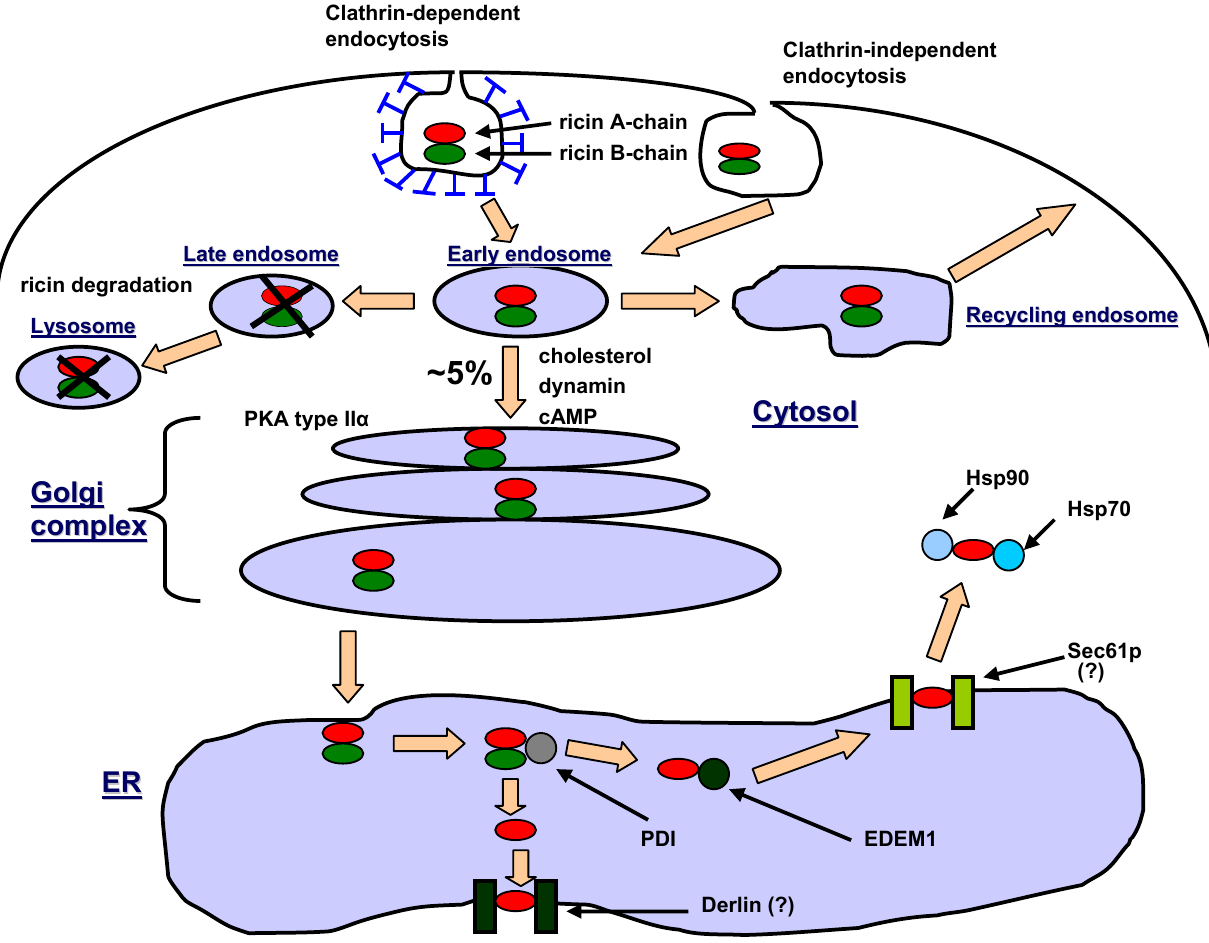
Figure 2. Intracellular transport of ricin. Ricin endocytosis can occur both by clathrin- dependent and clathrin- and caveolae-independent mechanisms. From early endosomes the majority of the endocytosed toxin recycles back to the cell surface, starts to be degraded and proceeds to late endosomes/lysosomes where further degradation is conducted. A minor fraction (~5%) of ricin is transported from early endosomes to the trans-Golgi network (TGN), circumventing late endosomes. As indicated, dynamin, cholesterol, cAMP and PKA type II α have been implicated in endosomes to Golgi transport of ricin. Ricin is further transported to the endoplasmic reticulum (ER). In the ER, protein disulfide isomerase (PDI) catalyses reduction of the internal disulfide bond connecting the ricin A-and B-chains. It is likely that enzymatically active A-chain is transported to the cytosol by utilizing Sec61p translocation channel. Probably, ricin can also be transported to the cytosol through Derlin translocation channel. ER degradation enhancing α -mannosidase I-like protein, EDEM1 is directly involved in ricin transport to the cytosol. Hsc70 and Hsp90 cytosolic chaperone machines are involved in RTA folding after retrotranslocation to the cytosol. For references, see the main